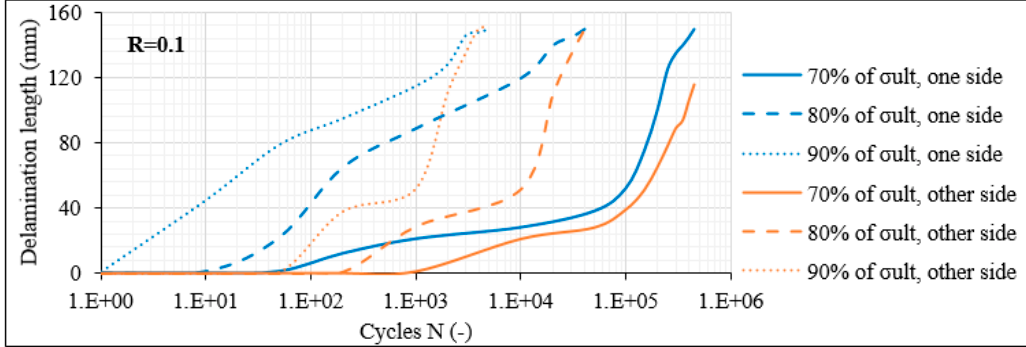
◦ /30 ◦ ] 2s laminates for R =